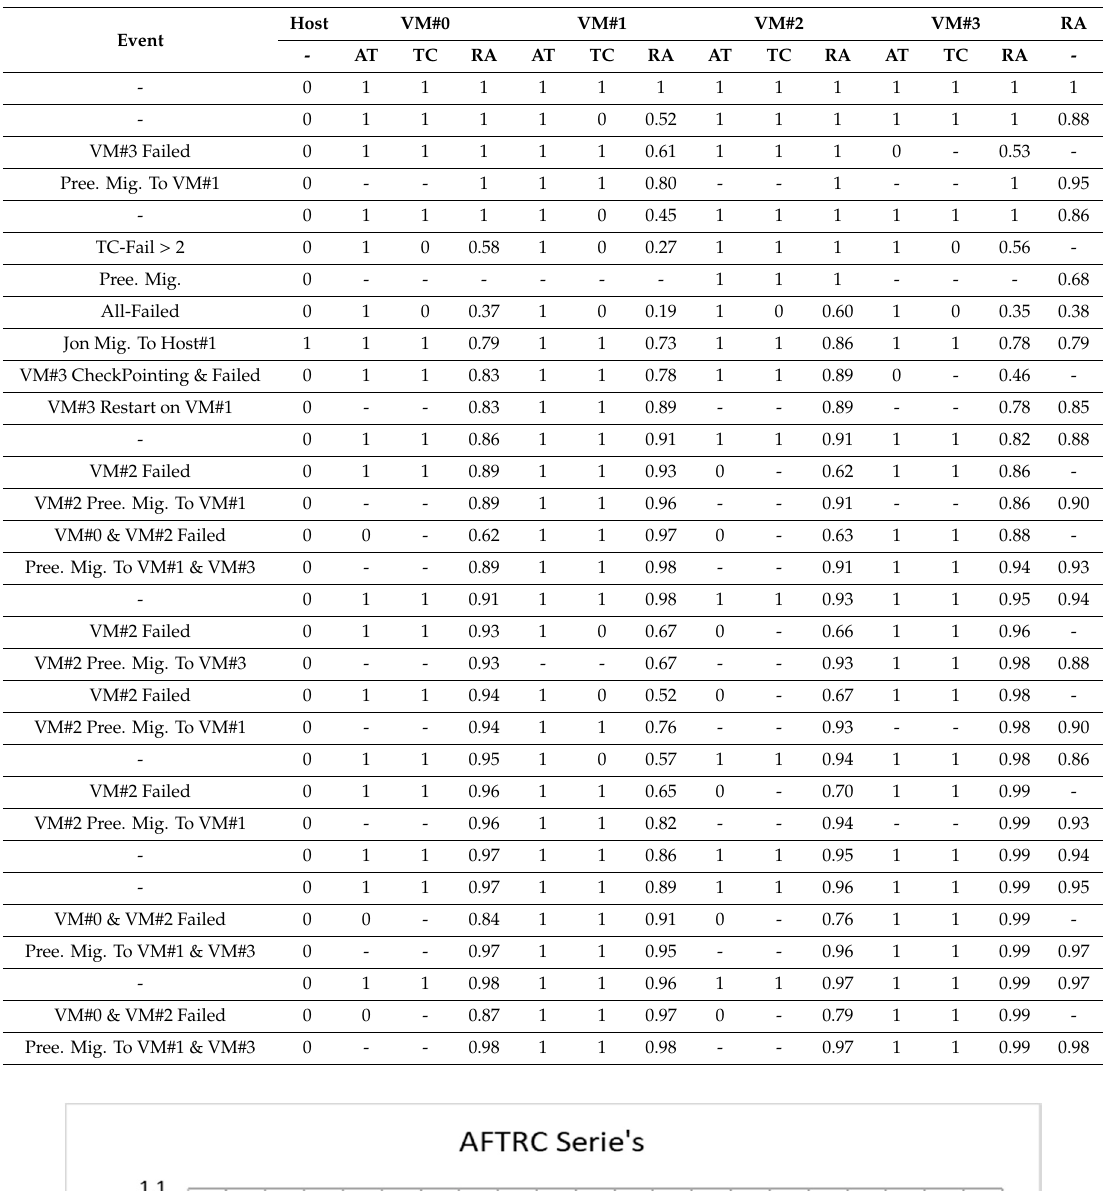
Table 5. Results of Simulating PrP-FRC in CloudSim.